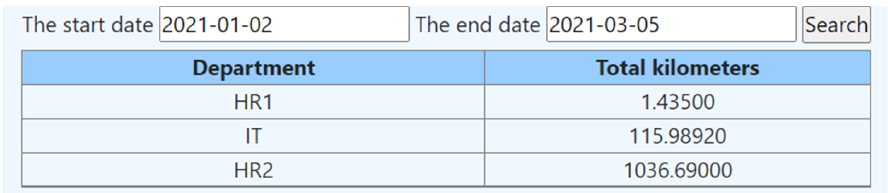
Figure 40. Sector kilometers menu.